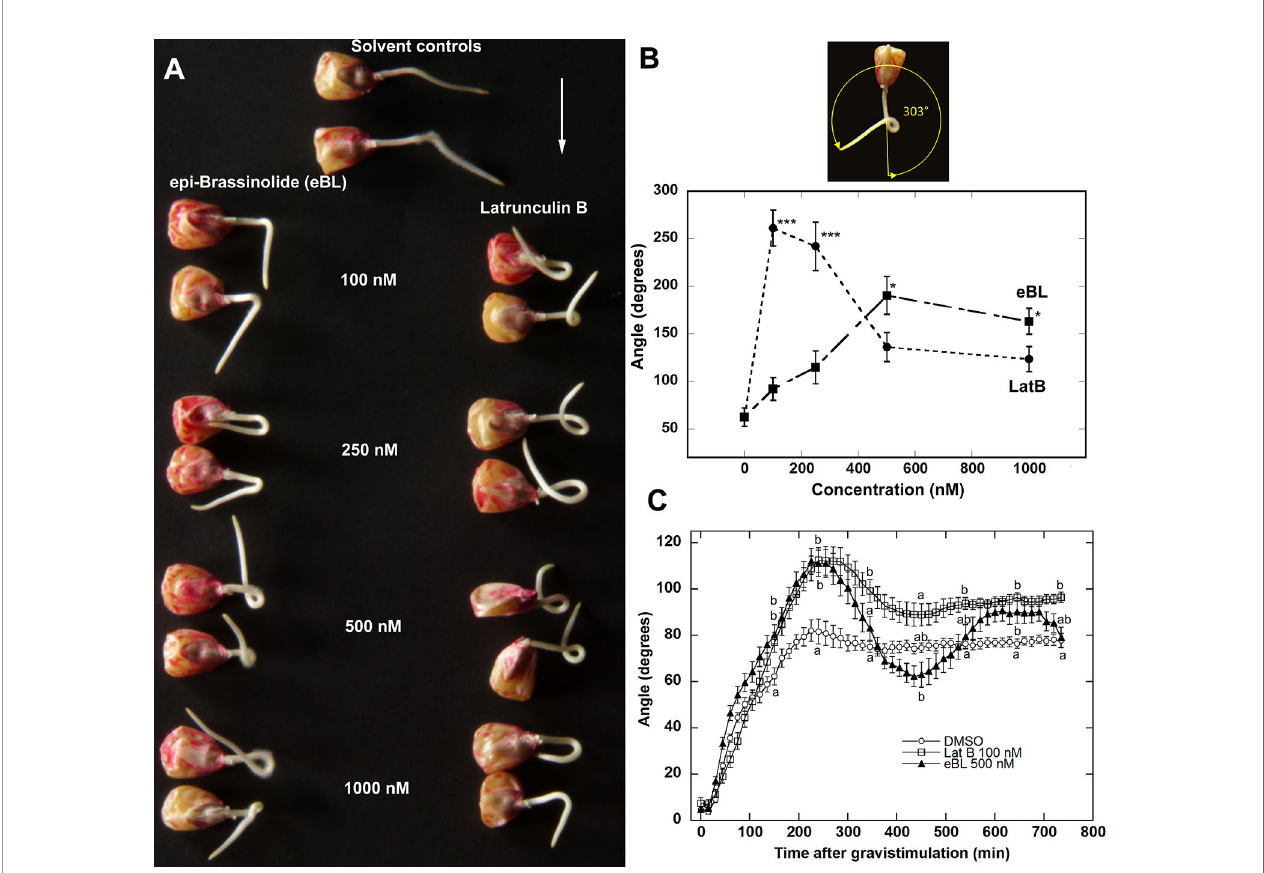
FIGURE 1 | Epi-Brassinolide (eBL) and LatB enhanced gravitropism and dampened straightening of Z. mays roots. (A) Representative images of Z. mays roots grown on a 2-D clinostat for 20 h to test autotropic straightening after withdrawal of the gravity signal. Vertical roots treated with LatB and eBL for 1 h were mounted on a 2-D clinostat and kept horizontal for 20 min (white arrow indicates the direction of gravity) prior to clinorotation for 20 h. Note that untreated roots (solvent controls) straightened after reaching an angle of about 45° while roots treated with eBL or LatB did not. (B) Dose response of root curvature on a clinostat after eBL and LatB treatment. Angle of curvature was obtained as shown by the yellow arrow above the graph. Bars are means (n > 14 plants) ± S.E. ***P < 0.001, * P < 0.05 (Student ’ s t-test). (C) Time course of root gravitropism after vertically growing roots were placed horizontally without clinorotation. Statistical signi fi cance was determined by one-way ANOVA. Means (n > 12 plants) ± S.E. Different letters indicate signi fi cant differences among means (P < 0.05, Tukey ’ s